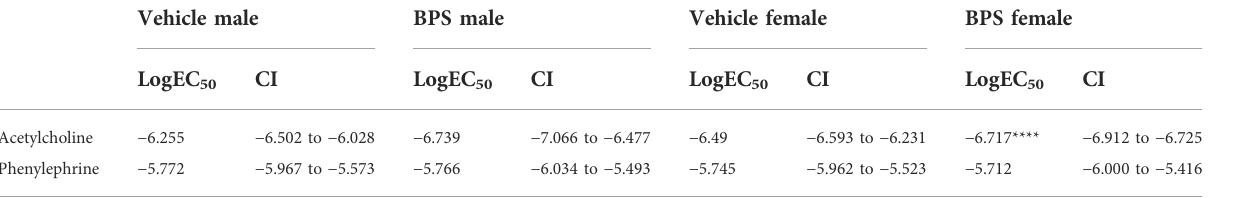
TABLE 2 EC 50 values of aortae acutely exposed to vehicle or